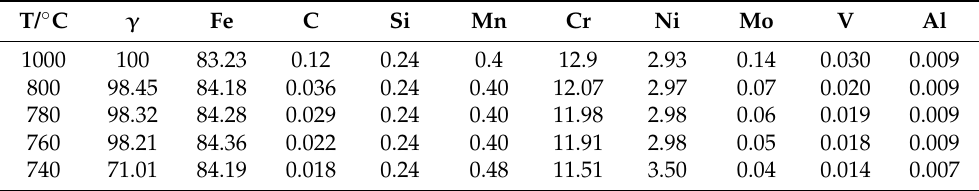
Figure 1. ThermoCalc thermodynamic calculations, ( a ) quasi binary Ni phase diagram with marked PK993 chemical composition, ( b ) thermodynamically stable phases in PK993, calculated by ThermoCalc. Table 3. Amount of austenite (wt%) and its composition (wt%) at intercritical annealing temperatures calculated with ThermoCalc.